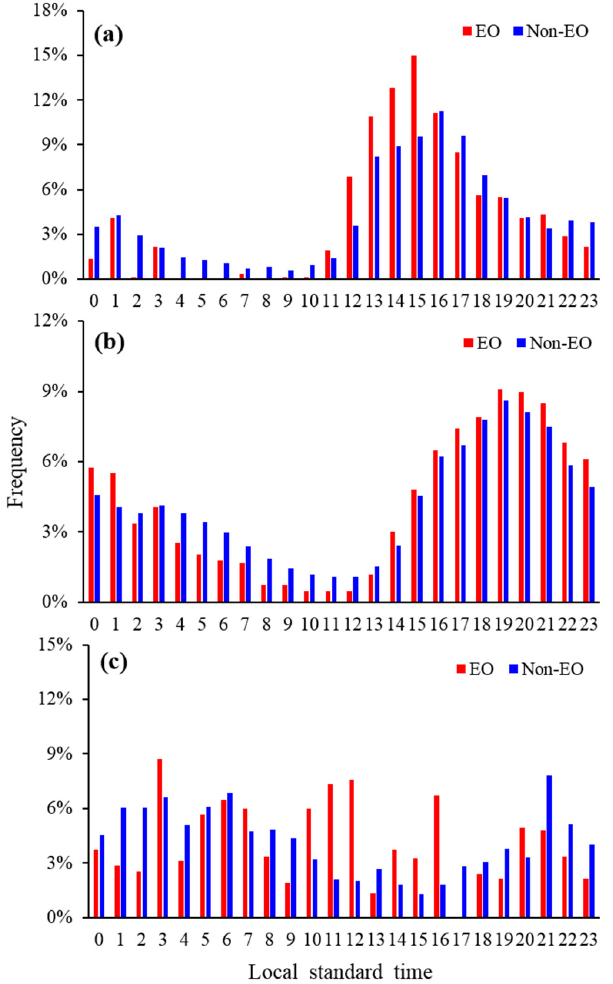
Figure 11. Diurnal variation of EOs (red) and non-EOs (blue) from 2013 to 2019. ( a ) Initiation time; ( b ) formation time; ( c ) dissipation time.